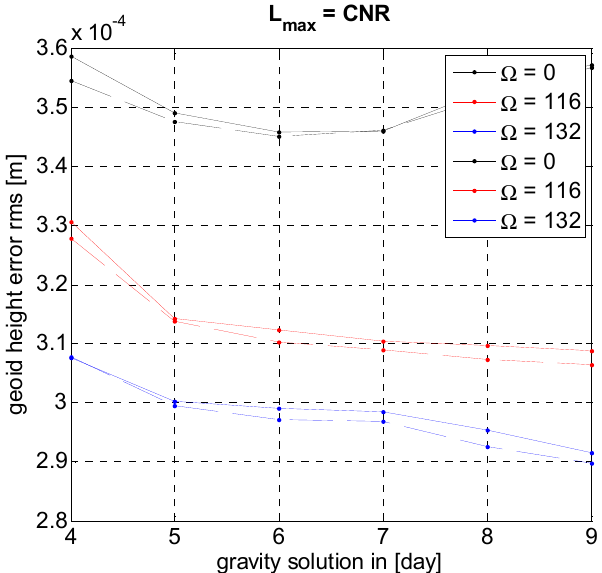
Figure 14. Global error RMS in terms of geoid height for odd (solid line) and even (dashed line) parities (Pendulum scenarios (a) and (b) of the Table 2, respectively) for the gravity solutions up to maximum spherical harmonic degree and order CNR. Different colors stand for different Ω .